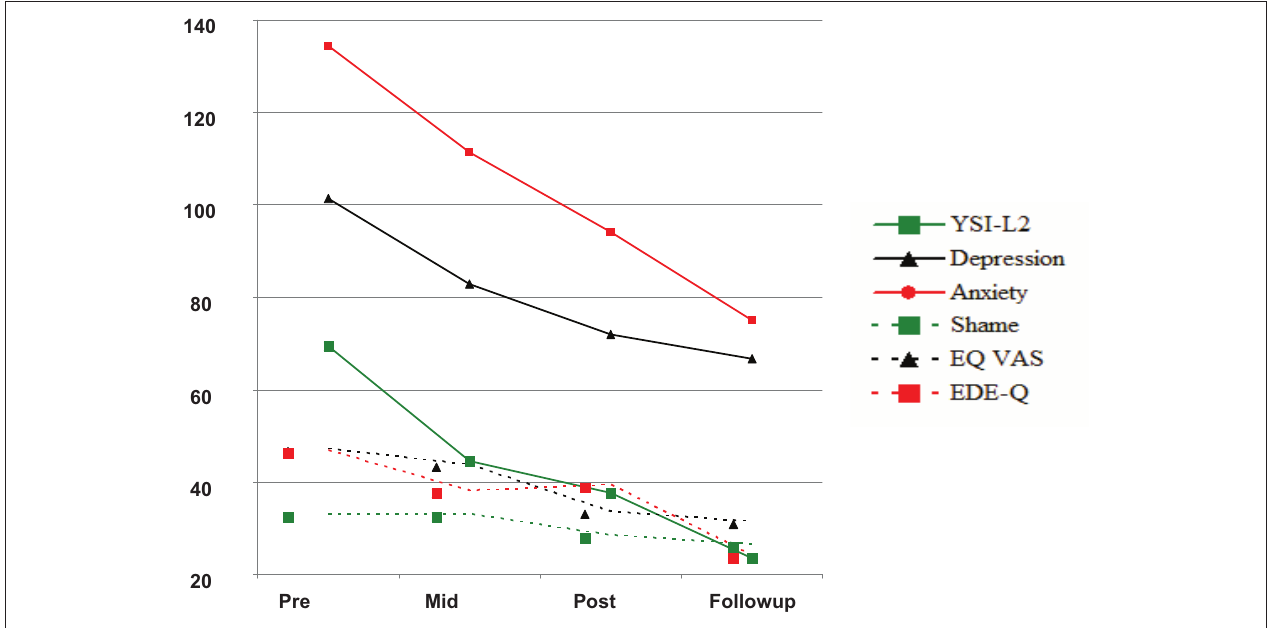
FIgurE 1 | group mean scores on YSI-L2, depression (HADS), anxiety (HADS), Shame, EQ-VAS, EDE-Q from pre-treatment through mid, post, and